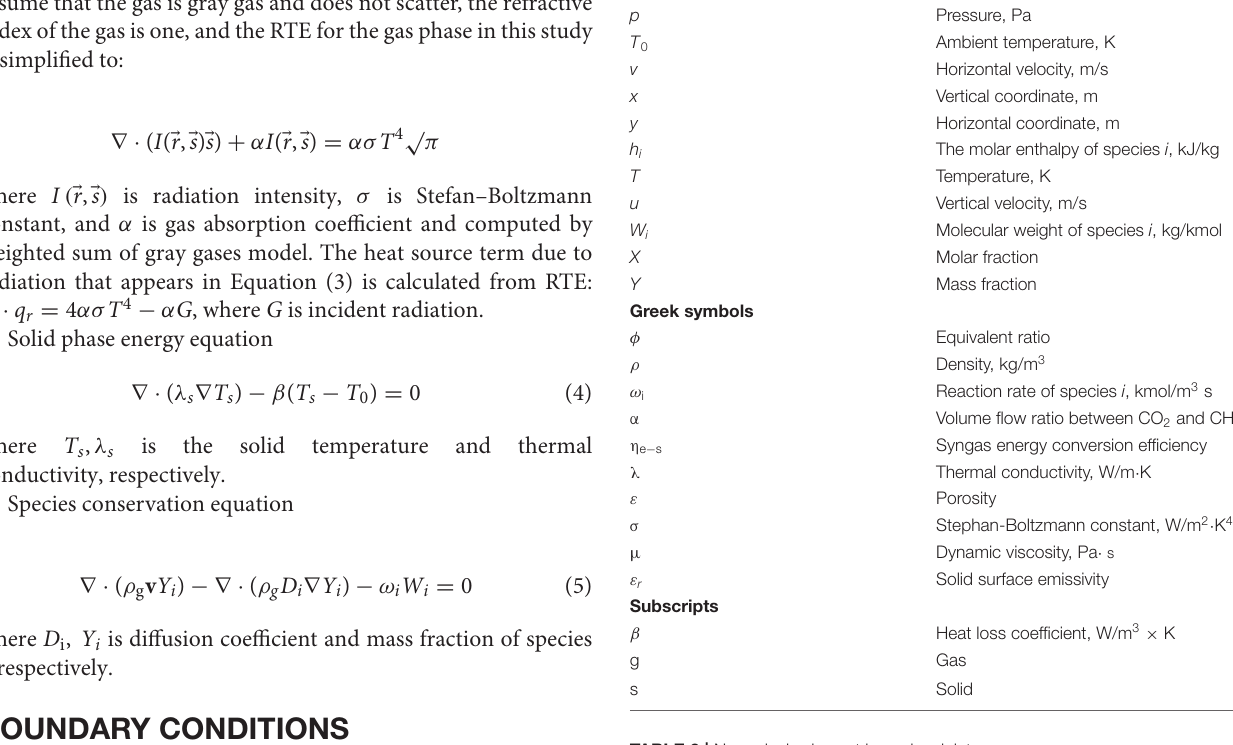
TABLE 2 | Numerical values at boundary